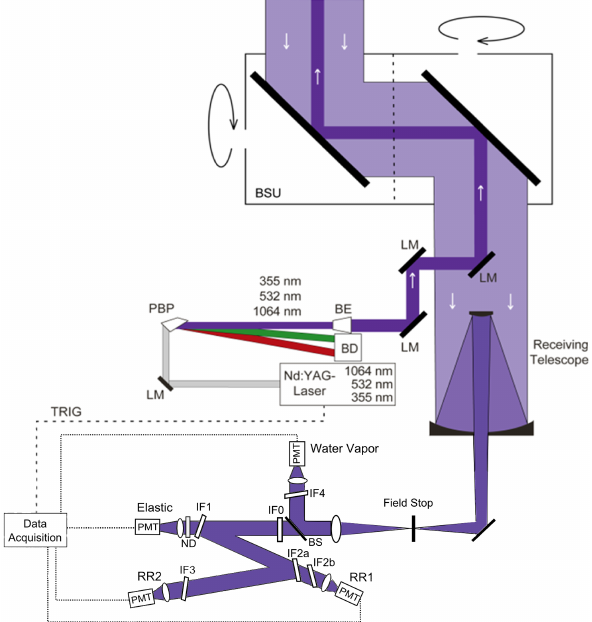
Figure 3. Setup of the rotational Raman lidar of the University of Hohenheim. LM stands for laser mirror, and the wavelengths are separated by a Pellin–Broca prism. Whereas 532 and 1064nm are sent to a beam dump (BD), 355nm is expanded by a beam expander (BE) and sent to the atmosphere through the beam steering unit (BSU). Angles in the polychromator are enlarged for clarity. IF0 is a daylight oppressing filter (see Table 1 for details). IF1 to IF4 are the interference filters, BS is a beam splitter to separate the vi- brational Raman lines from the elastic backscattered and rotational Raman signal. In front of the elastic channel a neutral density filter (ND) is mounted. Photomultipliers are marked with